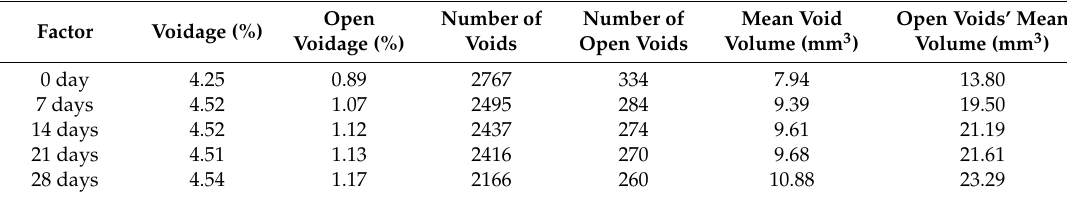
Table 13. Void Calculation Data for the AC4 specimen (Brine under Dry and Wet Cycling